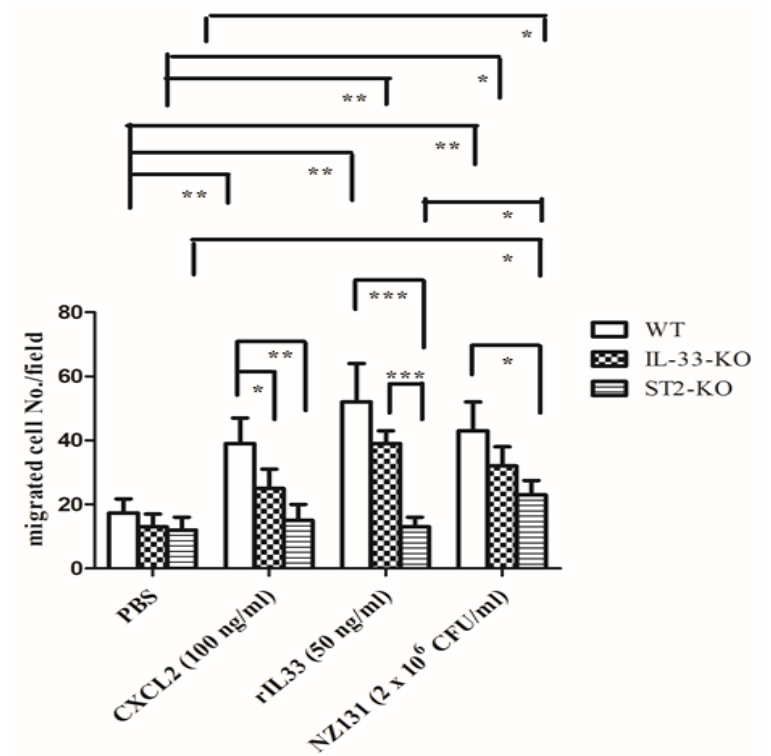
Figure 4. Effects of chemotaxis activities of neutrophils by different stimulants. The neutrophils of WT, IL - 33 -KO and ST2 -KO mice were collected from bone marrow as described in Materials and Methods, and were stimulated by different stimulants using the transwell assay. The chemotaxis activity was examined by migrated cell numbers per HPF. Five HPFs were selected and counted in each group and the results are expressed as the mean ± standard deviation. Treatment groups were compared for significance using ANOVA. * p < 0.05, ** p < 0.01, *** p < 0.001 compared with the relative groups as shown in the figure.